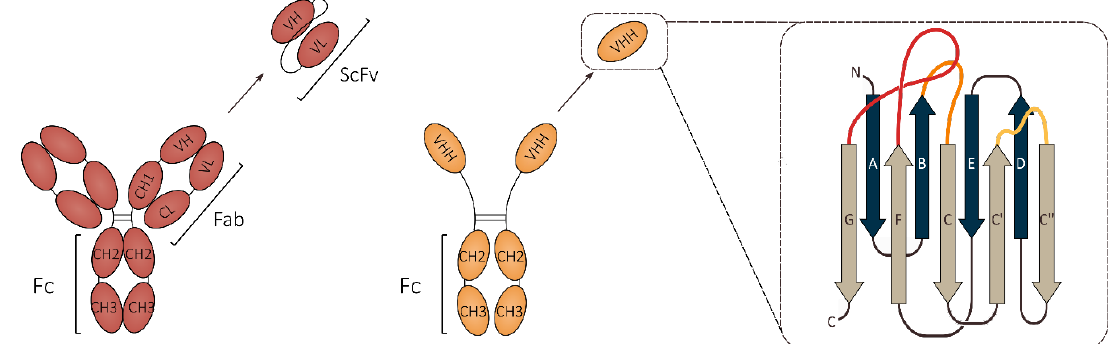
Figure 1. Schematic representation of a conventional IgG antibody ( left ) and a camelid heavy chain antibody ( middle ), with their respective smallest antigen-binding formats: a single chain variable fragment (ScFvs) and a single domain antibody (VHH). To the right, a folded VHH domain is schematically shown with CDR 1, 2 and 3 indicated in orange, yellow and red, respectively. CH: heavy chain constant domain; CL: light chain constant domain; VH: heavy chain variable domain; VL: light chain variable domain; VHH: variable domain of heavy chain antibody.